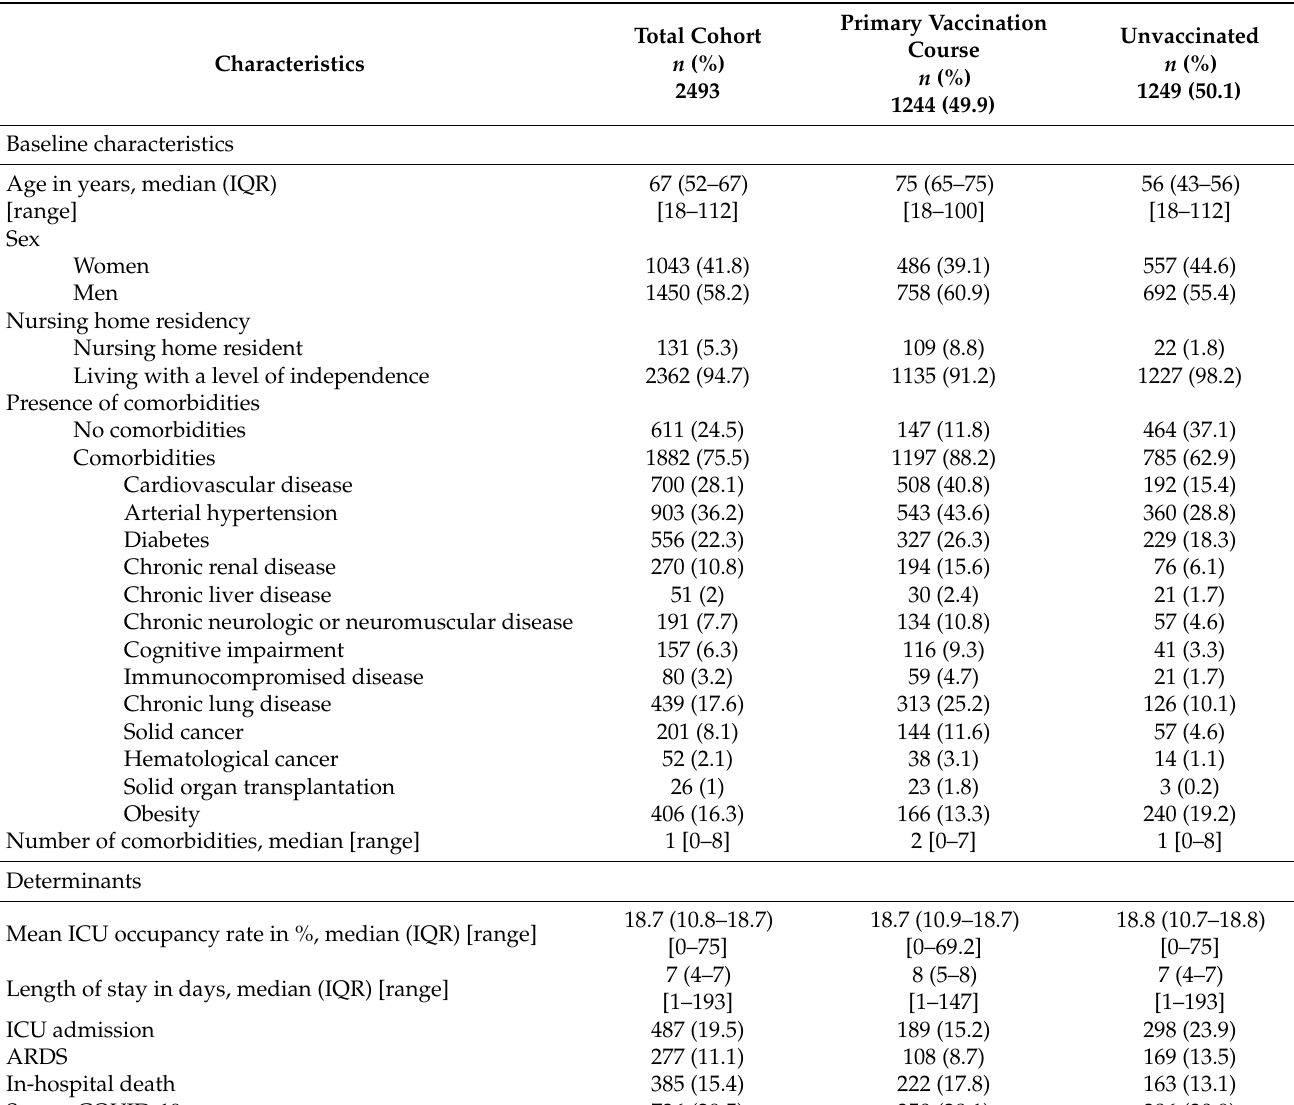
Table 1. Description study population (complete